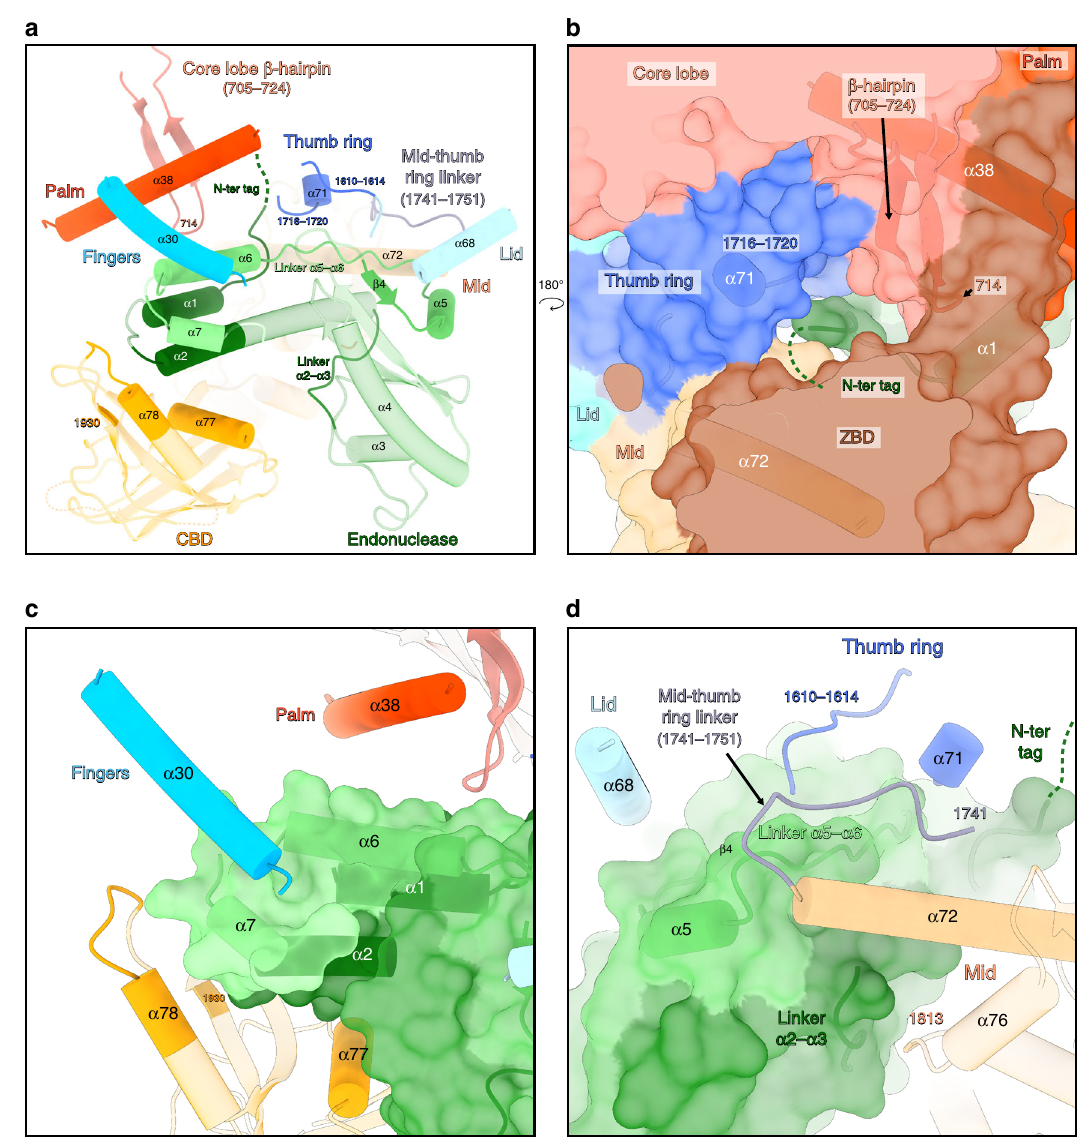
Fig. 2 Interactions of the endonuclease with the other polymerase domains. a Overview of the endonuclease interactions with the other polymerase domains. LACV-L orientation is the same as in Fig. 1c. Secondary structures and residues interacting with different parts of the endonuclease are shown in non-transparent and labeled. The endonuclease is colored from dark green on the N-terminus to light green on the C-terminus. The core lobe, fi ngers, thumb ring, lid, mid-thumb ring linker, mid, CBD are colored as in Fig. 1a. b Close-up view of the endonuclease N-terminus. Transparent surface of the polymerase is shown. The secondary structures of the core lobe and thumb ring domains that interact with the N-terminal tag are displayed, labeled and colored as in a . The N-terminal tag is represented as a dark green dotted line. c Close-up view of the interactions between the endonuclease and the following LACV-L domains: fi ngers, palm and CBD. The endonuclease is displayed as a transparent surface and colored as in a . d Close-up view of the interactions between the endonuclease and the following LACV-L domains: thumb ring, lid, mid-thumb ring linker and mid. The endonuclease is displayed as in c . The secondary structures are labeled and the N-terminal tag is represented as a dark green dotted